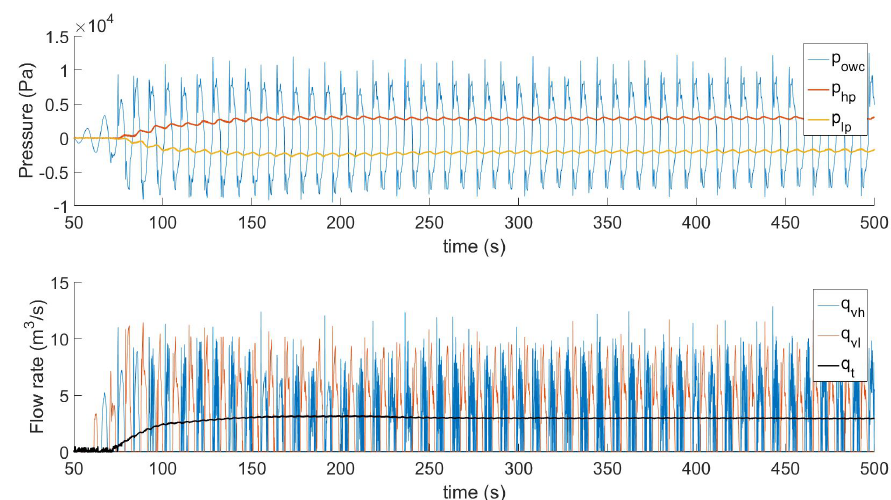
Figure 15. Time series of pressures in the chambers and flows across the valves and turbine for a 2 m-high regular wave of a nine-second period (full-scale equivalent) obtained in tank testing.